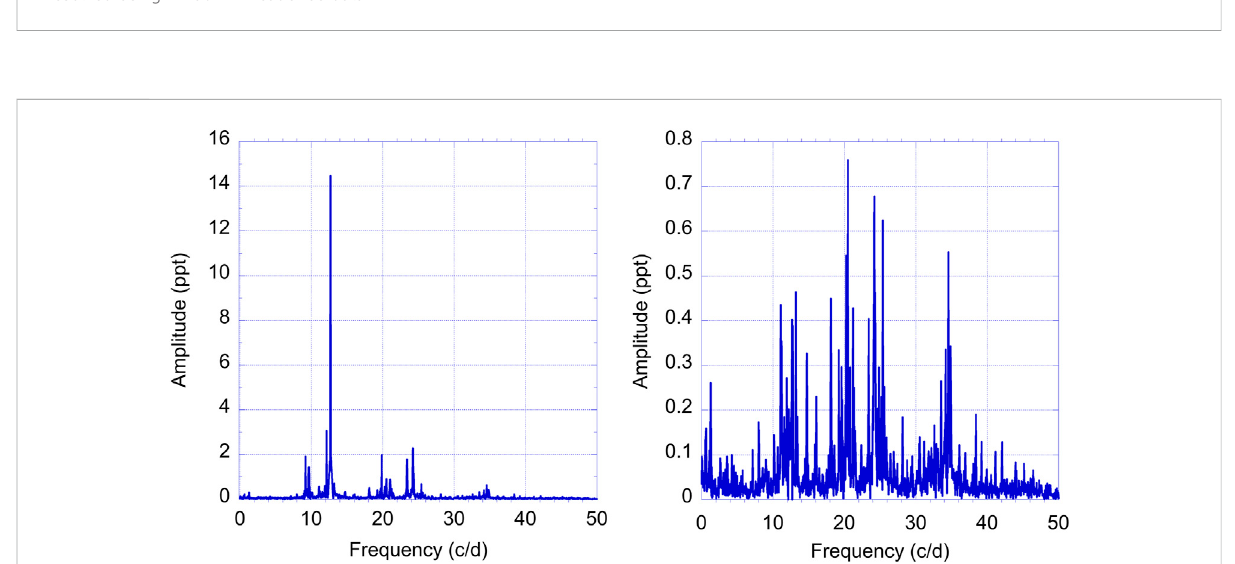
FIGURE 4 Left: FG Vir amplitude spectrum from TESS 2-min cadence data. Right: Amplitude spectrum after pre-whitening modes with amplitude > 1